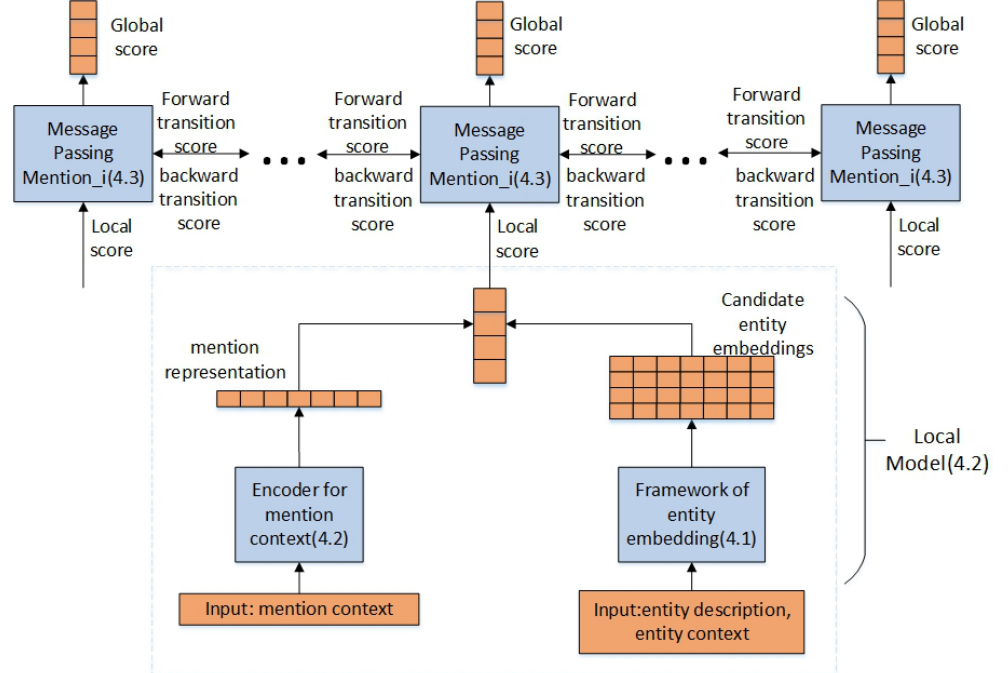
Figure 2. Overview of the model. The input of the encoder for the mention context is the mention context and the inputs for entity embedding are the entity description and the entity context.